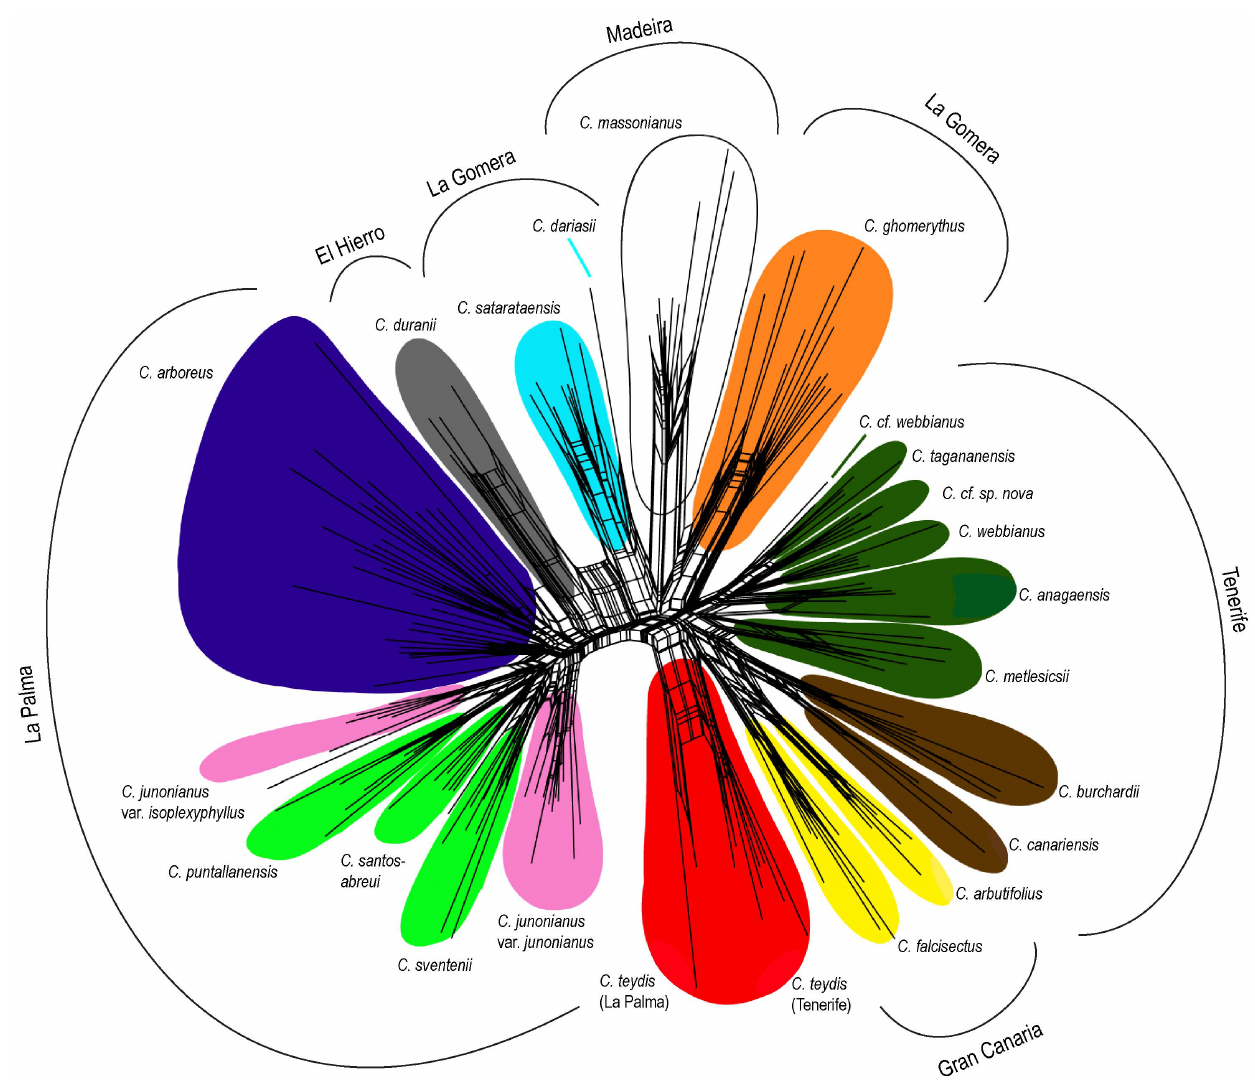
Figure 3. Neighbor-Net of AFLP data obtained from Macaronesian Cheirolophus . Colour coding profiles delimitate the different species indicating the genetic clusters assigned by BAPS.